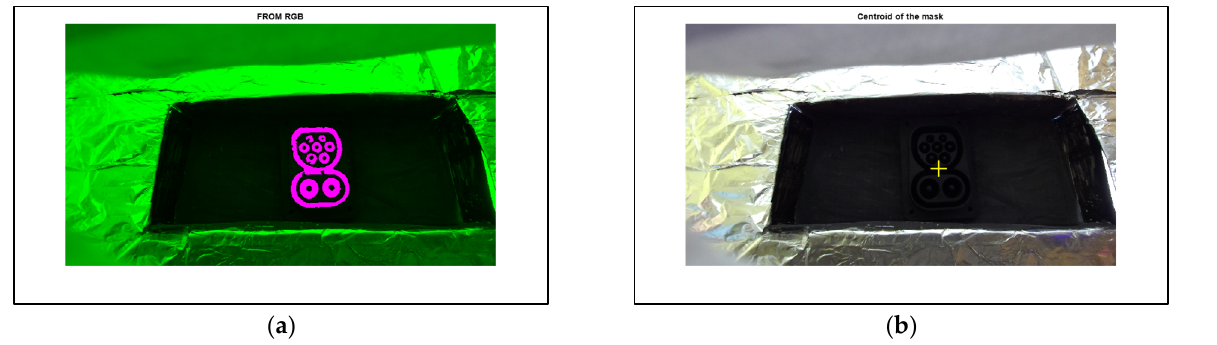
Figure 9. ( a ) Overlapped image of the extracted CCS2 socket and ( b ) marked centroid coordinate of the CCS2 socket in the original input image.